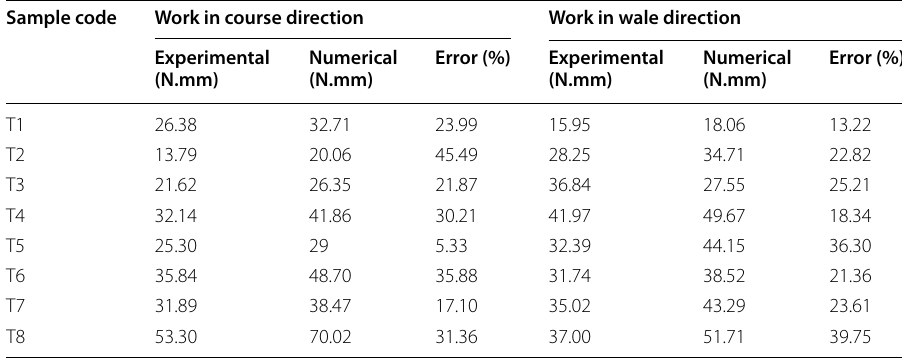
Table 6 Work values for experimental and numerical results with the error values Sample code Work in course direction Work in wale direction Experimental